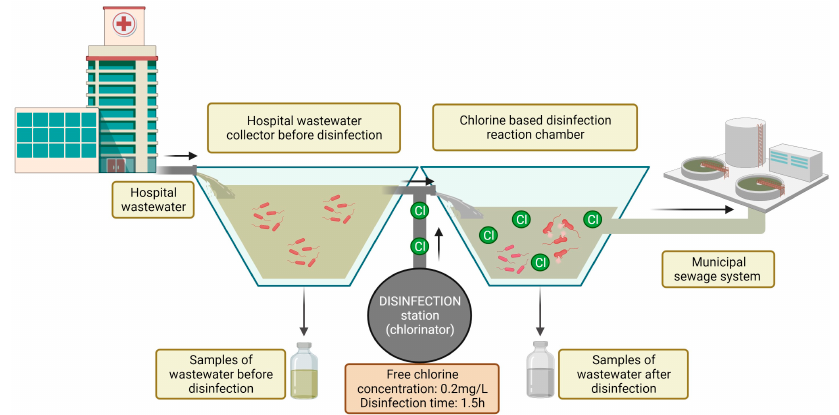
Figure 1. Diagram of the study site and the sampling procedure.